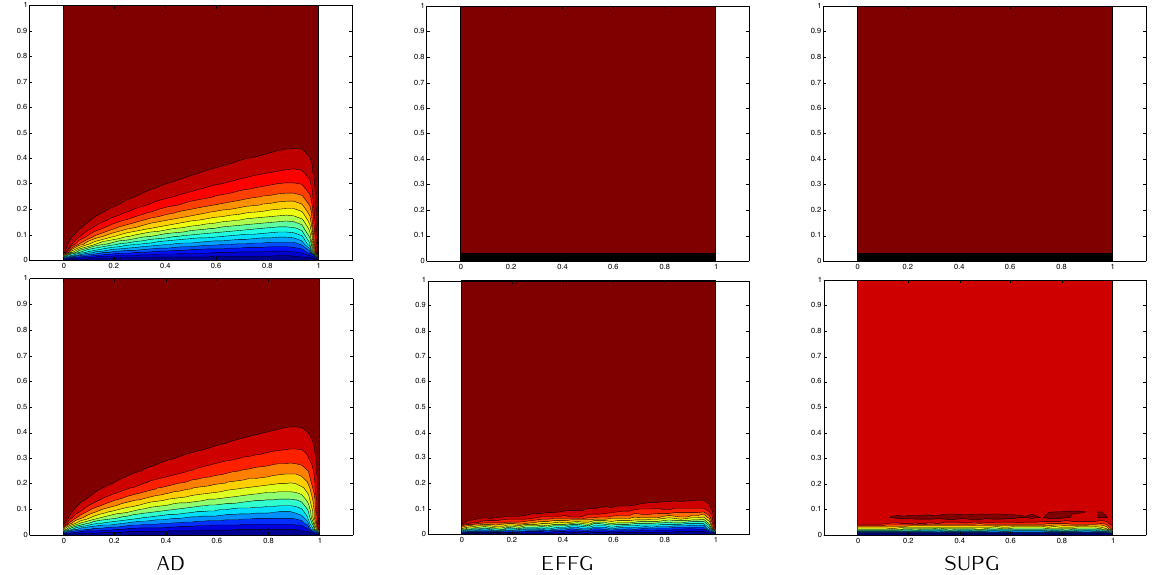
Figure 2. Solution of the horizontal advection test problem (29) with ε = 0 . 00001 by AD (left) vs. EFFG (middle) and SUPG (right) on 33 × 33 grids. Top row: uniform grid. Bottom row: randomly perturbed grid.